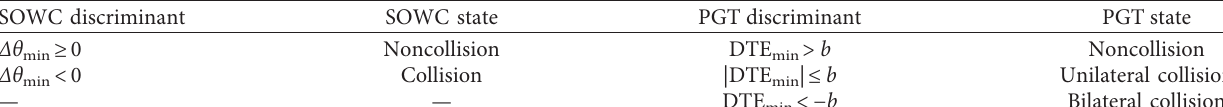
Table 2: Discriminant of collisions.